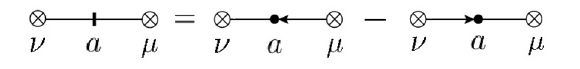
is denoted by an arrow line pointing towards node a and (cid:15) ν is denoted by a Figure 19 . When k µ a line with no arrow, the strength tensor F µν can always be decomposed into the difference of the two a graphs on the r.h.s.